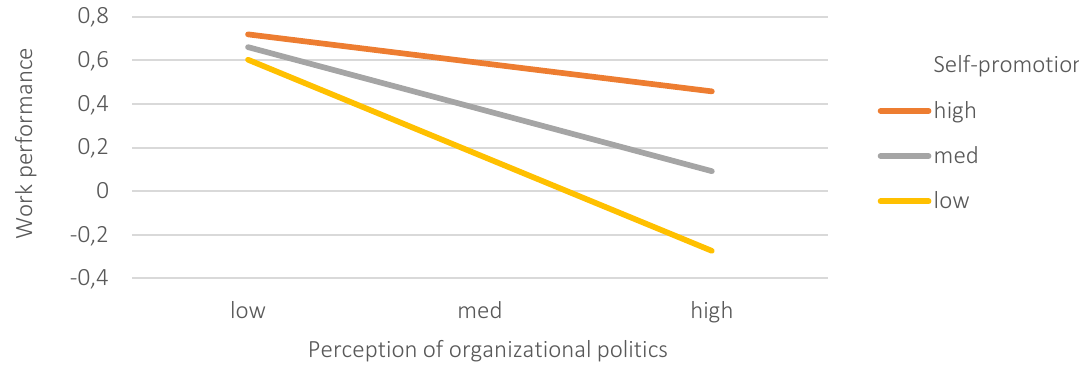
Figure 1. Interactive effect of perception of organizational politics and self-promotion on work